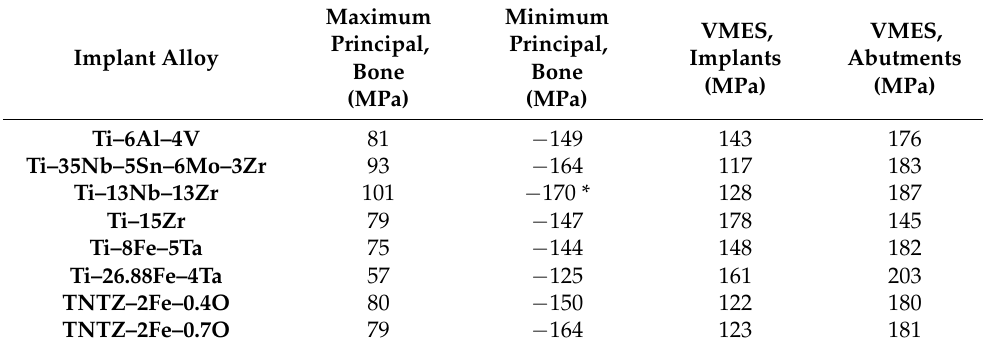
Table 3. Principal stresses and VMES values for alloy simulated in the implant of 2.9 mm in